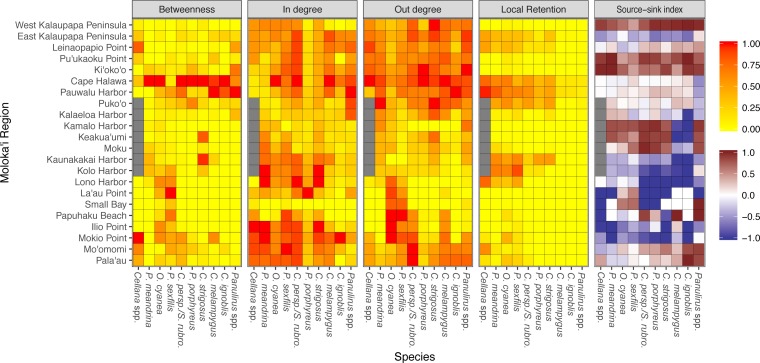
Region-level summary statistics across all species.Betweenness centrality is a measure of the number of paths that pass through a certain region; a high score suggests potentially important multi-generation connectivity pathways. In-degree and out-degree refer to the amount of a node’s incoming and outgoing connections. Betweenness centrality, in-degree, and out-degree have all been normalized to values between 0 to 1 per species. Local retention is measured as the proportion of larvae that settled back to their spawn site out of all larvae spawned at that site. Source-sink index is a measure of net export or import; negative values (blue) indicate a net larval sink, while positive values (red) indicate a net larval source. White indicates that a site is neither a strong source nor sink. Gray values for Cellana spp. denote a lack of suitable habitat sites in that particular region.